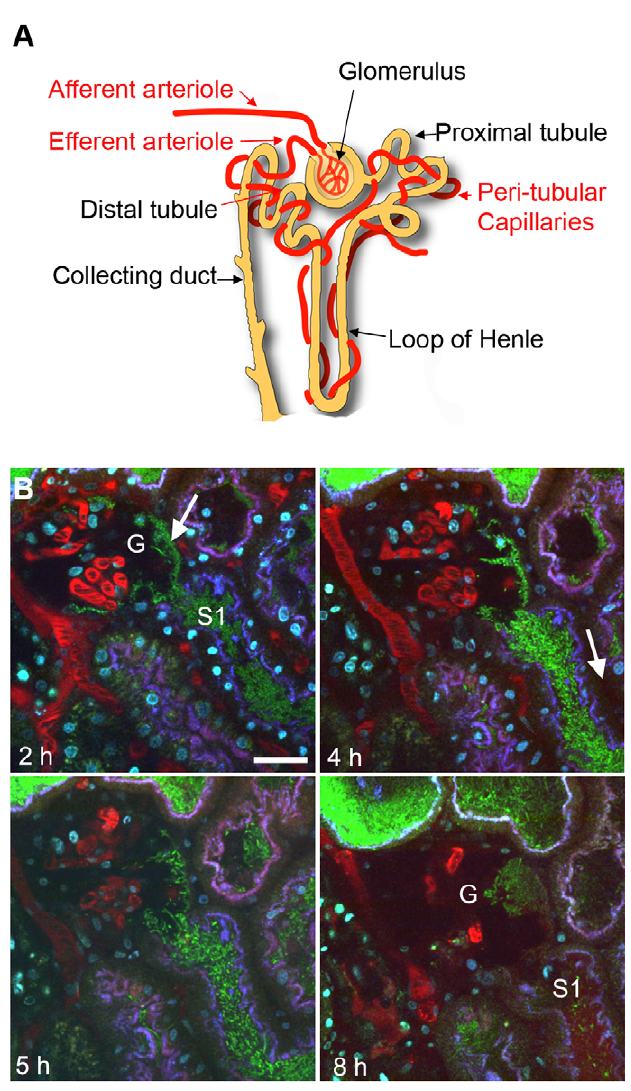
Figure 1. UPEC attachment in Bowman’s capsule. ( A ) Schematic showing nephron structure. ( B ) Dynamic imaging of LT004 infused directly into Bowman’s capsule. ( 2 h ) Bacteria (green, arrow) conformally lining to Bowman’s capsule epithelia of a glomerulus (G) and in the early proximal tubule segment (S1). Proximal tubule epithelium is outlined by endocytosed 10 kDa cascade-blue labeled dextran (blue). Blood plasma is labeled with 500 kDa rhodamine dextran (red). Hoechst 33342 labels cell nuclei (cyan). ( 4–5 h ) Bacterial colonization within Bowman’s capsule and the proximal tubule is accompanied by reduced peritubular capillary blood flow (4 h, arrow). ( 8 h ) The glomerular capillary loops succumb to infection and the blood stops flowing (G). Scale bar =30 m